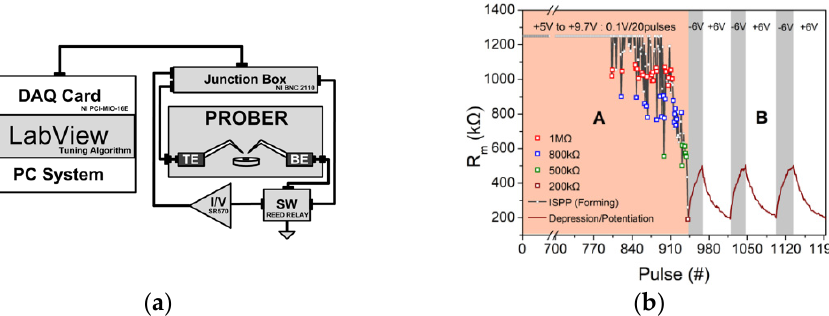
Figure 3. ( a ) Block diagram of the switching measurement experimental setup, ( b ) ISSP forming procedure is illustrated in region A, and three potentiation/depression cycles under pulses of 1 μ s width and ±6 V amplitude are illustrated in region B.